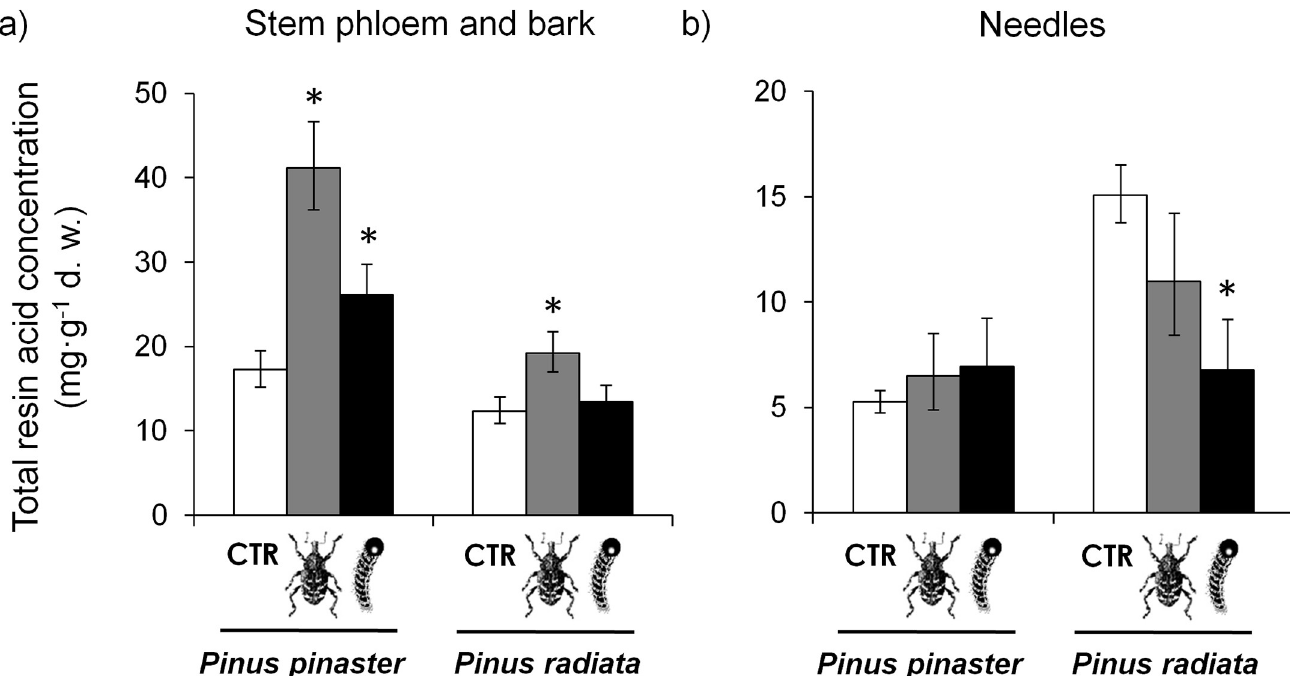
Fig 1. Local and systemic effects of damage by two chewing insect herbivores, the pine weevil (grey bars, a bark chewer) and the pine caterpillar (black bars, a defoliator) on the total concentration of resin acids in the stem phloem and bark (a) and in the needles (b) of pine seedlings of two species. LS means ± s.e. (N = 9–10). The asterisk above bars indicates significant differences with control plants within each species ( P < 0.05).